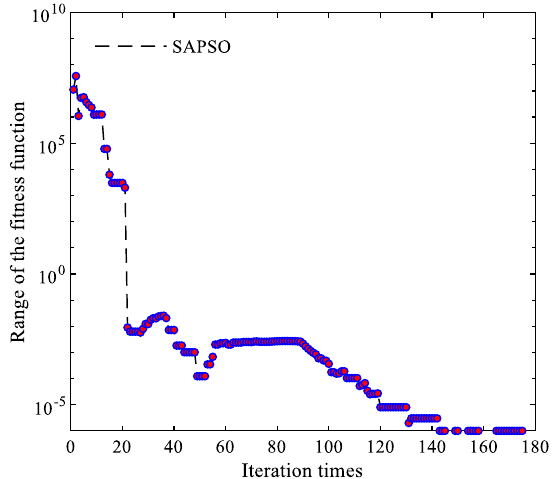
Fig. 4 The relationship between the range of fitness function and the number of iterations